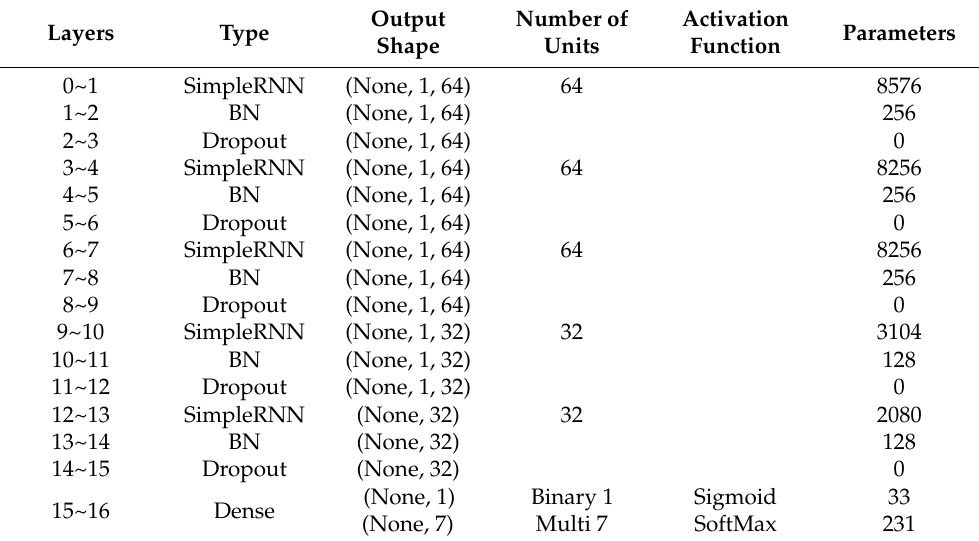
Table 11. RNN-5-256 (5 layers and 256